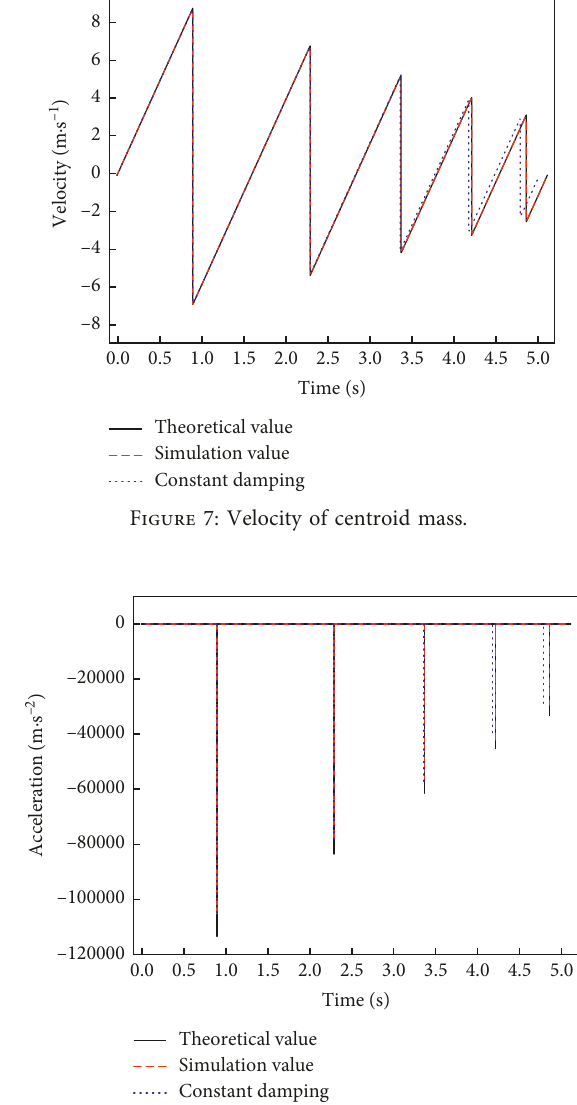
Figure 8: Acceleration of centroid